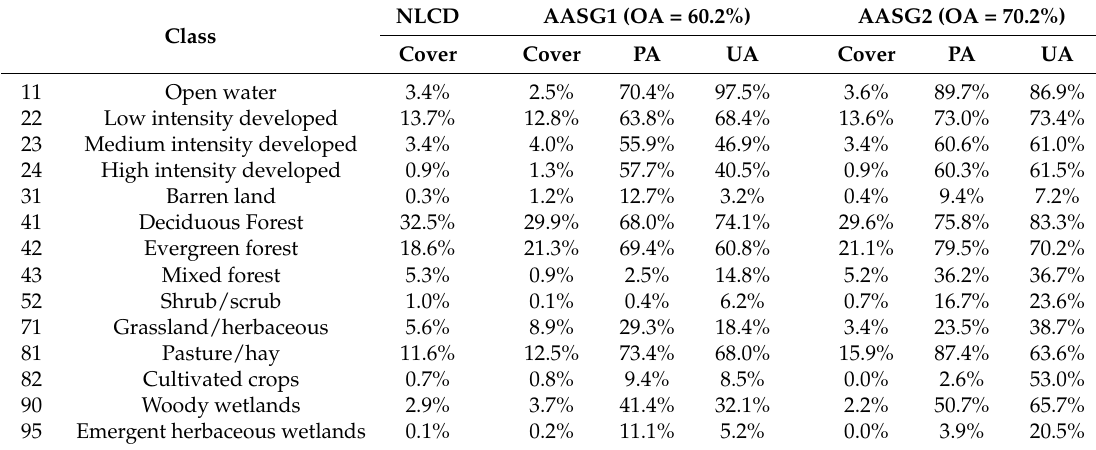
Table 2. Comparison of proportional land cover, overall agreement (OA), producer’s agreement (PA), and user’s agreement (UA) in 2006. Full confusion matrices are presented in Tables S1–S2.